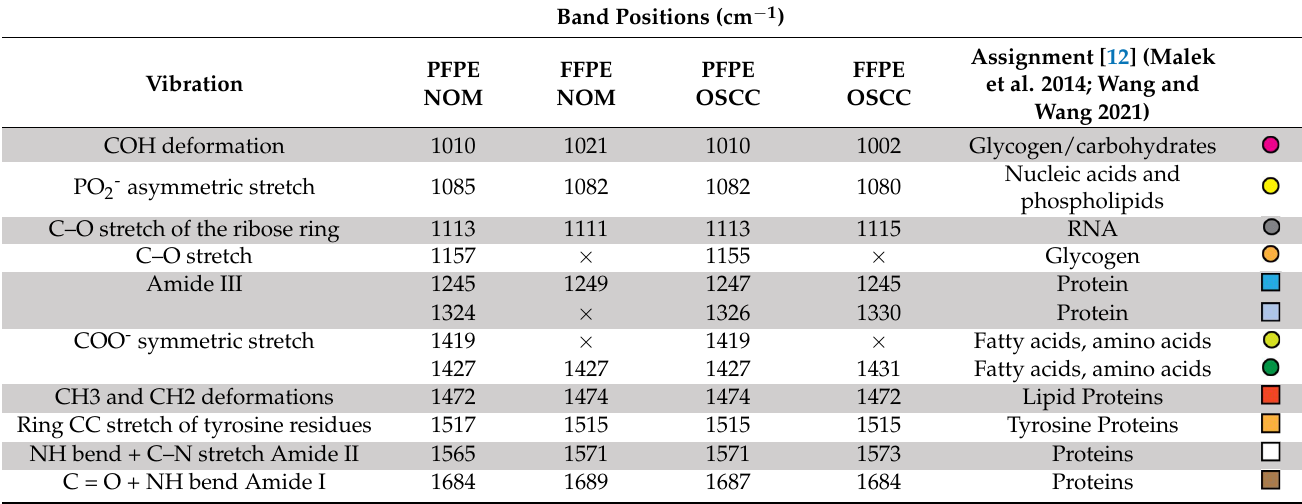
Colored shapes represent the assigned biomolecules, which can be correlated with spectra represented in Figure 5. Abbreviations: FFPE, formalin-fixed paraffin embedded; PFPE, PAXgene-fixed paraffin embedded; OSCC, oral squamous cell carcinoma; NOM, normal oral mucosa.